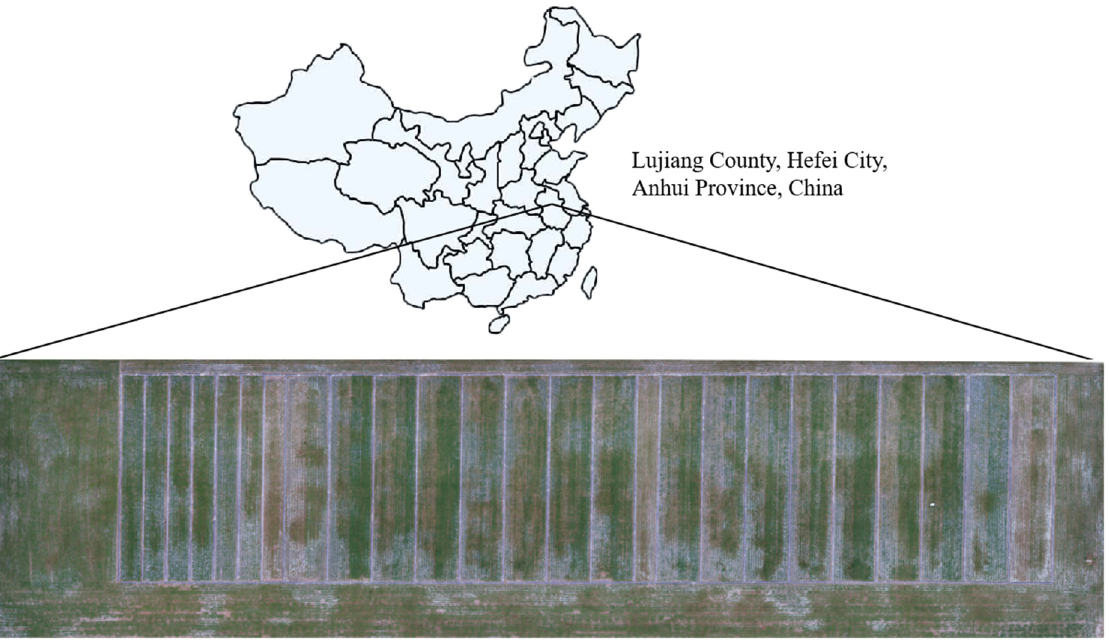
Figure 1. Study area. The aerial images were taken from Google maps on 25 June 2019. The Field photos were taken on 8 July 2019 by the RGB camera carried by DJI UAV.